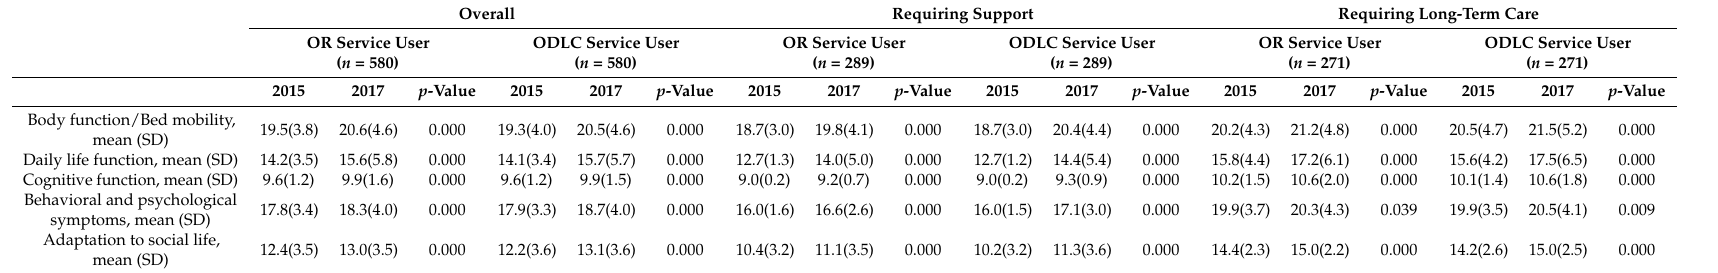
Table 4. Comparison of certification care-needs survey items between 2015 and